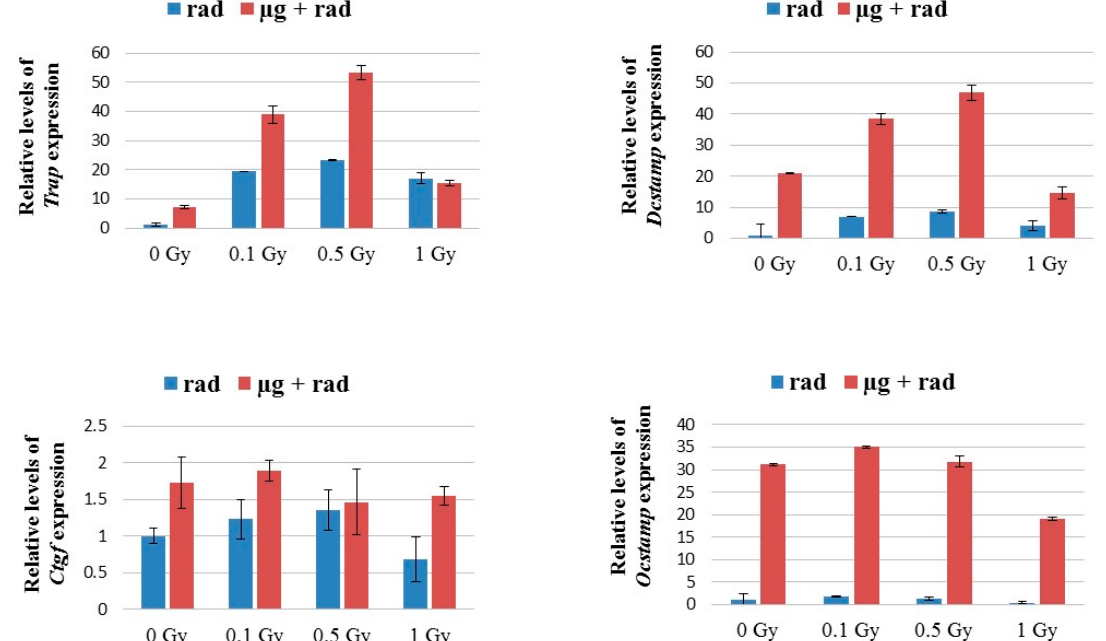
Figure 4. Expression of Trap , Ocstamp , Dcstamp , and Ctgf genes in response to different doses of gamma irradiation under the static (blue bars) and simulated microgravity (red bars) conditions. The increase in gene expression peaked at doses of 0.1–0.5 Gy. For all genes, except for Ctgf , expression was significantly higher in radiation + microgravity compared to radiation alone (two-way ANOVA of triplicates per each condition and dose; p = 0.0001).